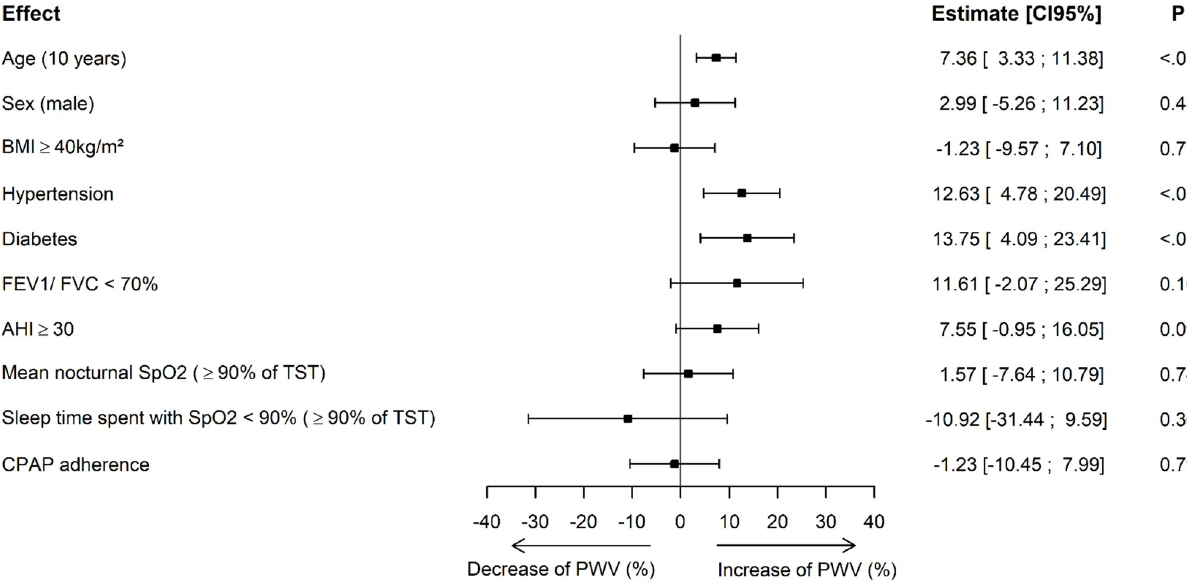
Fig 2. Univariate analysis. BMI, body mass index; FEV1, Forced Expiratory Volume in the first second of forced expiration; FVC, Forced Vital Capacity; AHI, apnea hypopnea index; TST, total sleep time, CPAP, continuous positive airway pressure. Interpretation: An increase of ten years in age is associated with a 7.36% increase in PWV. Having high blood pressure at baseline was associated with a 12.63% increase in PWV compared to normotensive patients. Having diabetes was associated with a 13.75% increase in PWV compared to patients without diabetes.